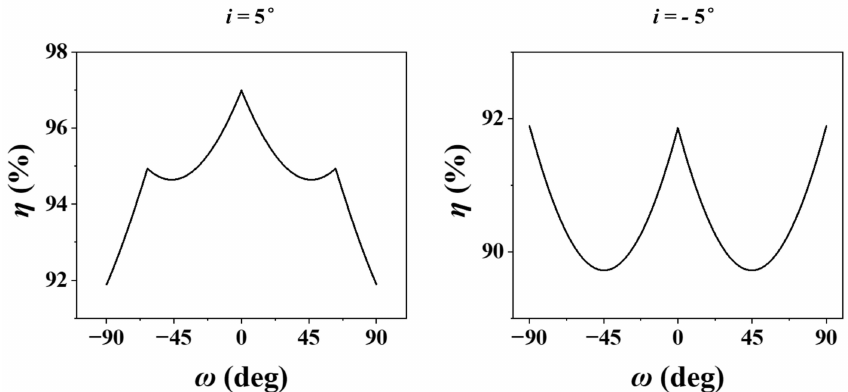
Figure 14. Luminous flux utilization as a function of ω when i = ± 5 ◦